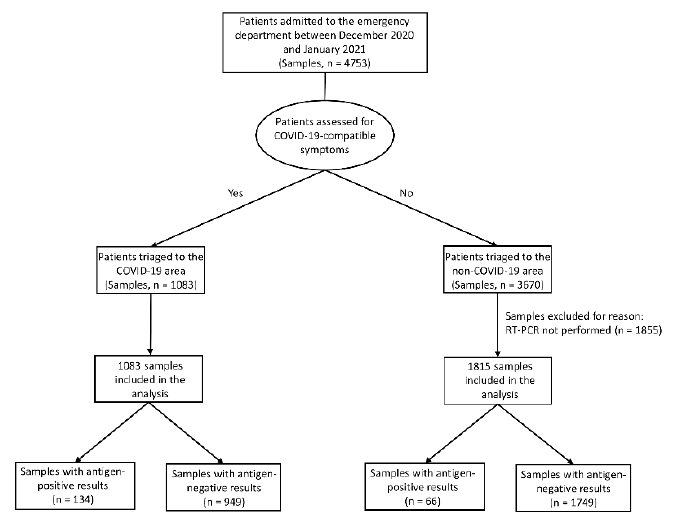
Figure 2. Flowchart of nasopharyngeal swab samples from patients triaged to COVID-19 or non- COVID-19 areas of the ED. Samples were tested for SARS-CoV-2 antigen with the SD Biosensor STANDARD F COVID-19 Ag FIA, yielding positive or negative results. Antigen results were compared with those obtained by RT-PCR for cases (1083 in the COVID-19 area, and 1815 in the non- COVID-19 area) in which confirmatory RT-PCR testing (performed within few hours from antigen testing) was required. Abbreviations: ED, emergency department; FIA, fluorescent immunoassay; COVID-19, coronavirus disease 2019; SARS-CoV-2, severe acute respiratory syndrome coronavirus 2; and RT-PCR, reverse-transcription polymerase chain reaction.